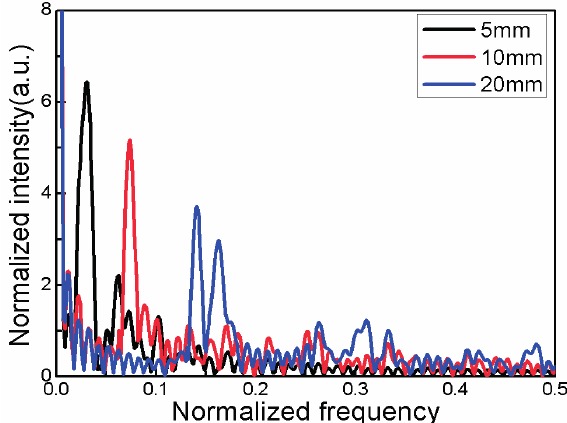
Figure 3. Spatial spectra of several interference spectra in Figure